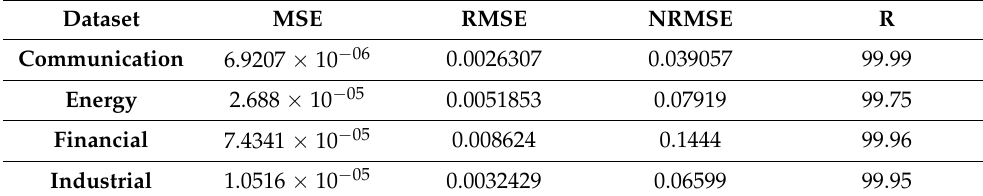
Table 3. Performance of the LSTM model in the testing